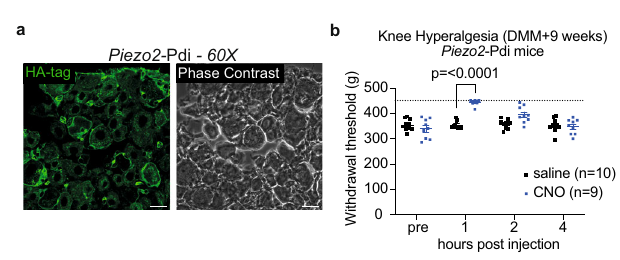
legs: 4 weeks (mean±SEM): wild-type (425±2) and Piezo2 CKOfl/fl (437±7). 8 weeks: wild-type (439±2) and Piezo2 CKOfl/fl (445±5). 12 weeks: wild-type (437±2) and Pie- zo2 CKOfl/fl (432±7). 16 weeks: wild-type (441±2) and Piezo2 CKOfl/fl (446±4). Two-way repeated measures ANOVA with Sidak post-test. An independent experiment is shown in Supplementary Fig. 6. c Hind paw mechanical allodynia was assessed in naivecontrolmice(littermatenocre, n =5,blacksquares)or Piezo2 CKOfl/fl ( n =8,blue circles)at1.5years of age.Histology showninSupplementaryFig.7.Unpaired two- tailed t -test on log-transformed data. Mean±SEM. For a – c , source data are pro- vided as a Source Data fi